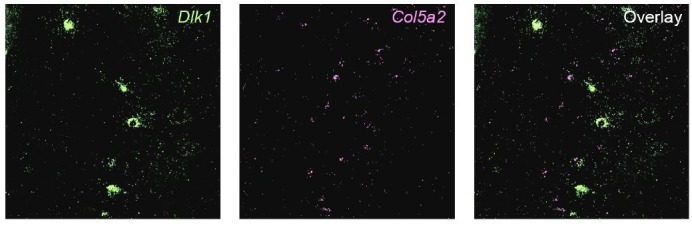
Two-color fISH of Dlk1 and Col5a2.Representative image of expression of Dlk1 (green) and Col5a2 (magenta) in an intermediate region of the subiculum.